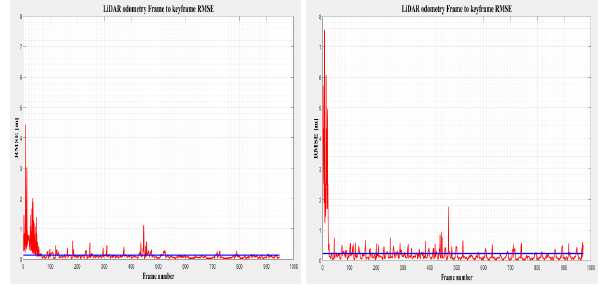
Figure 13. Registration error between successive scans by varying the payload rotation